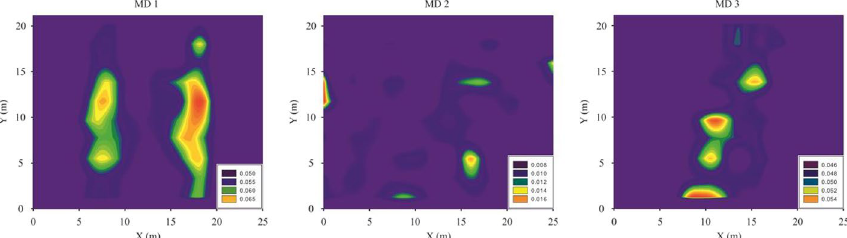
Fig. 20 Two-dimensional view of the detected damage extent for the 3 multiple damage scenarios in the presence of